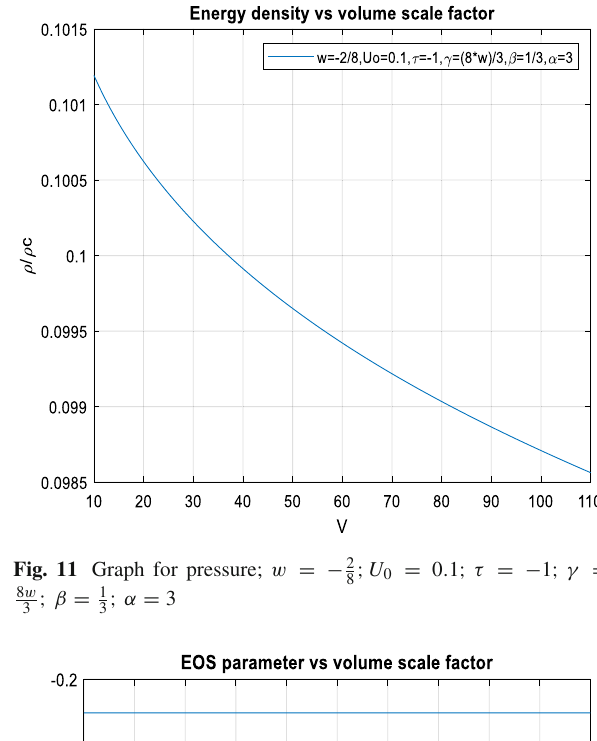
Fig. 9 Graph for internal energy w = − 2 ; β = 1 ; α = 3 8 w 3 3